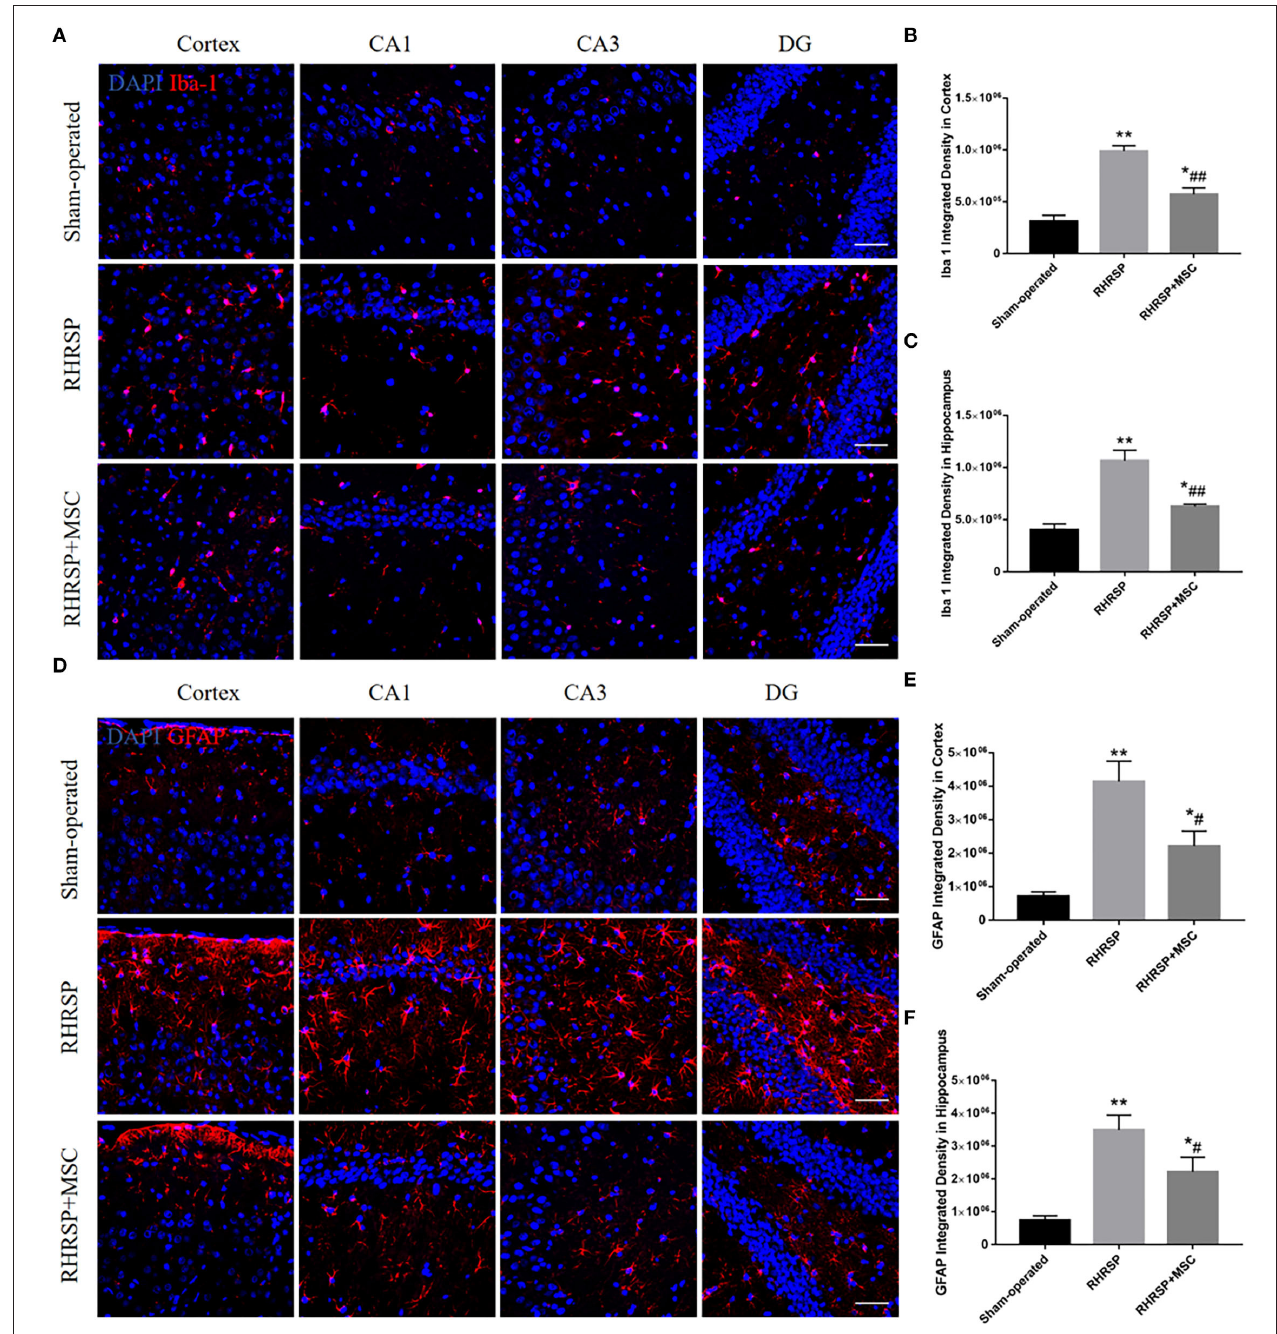
FIGURE 7 | Effects of MSCs treatment on the activation of microglia and astrocytes. (A,D) Representative images of immunofluorescence staining of Iba-1 and GFAP in the cortex and hippocampus. (B,C,E,F) Quantification of immunofluorescence staining for Iba-1 and GFPAP in the cortex and hippocampus (* P < 0.05, ** P < 0.01, vs. sham-operated group; # P < 0.05, ## P < 0.01, vs. RHRSP group; n = 6/group). scale bar = 50 µ